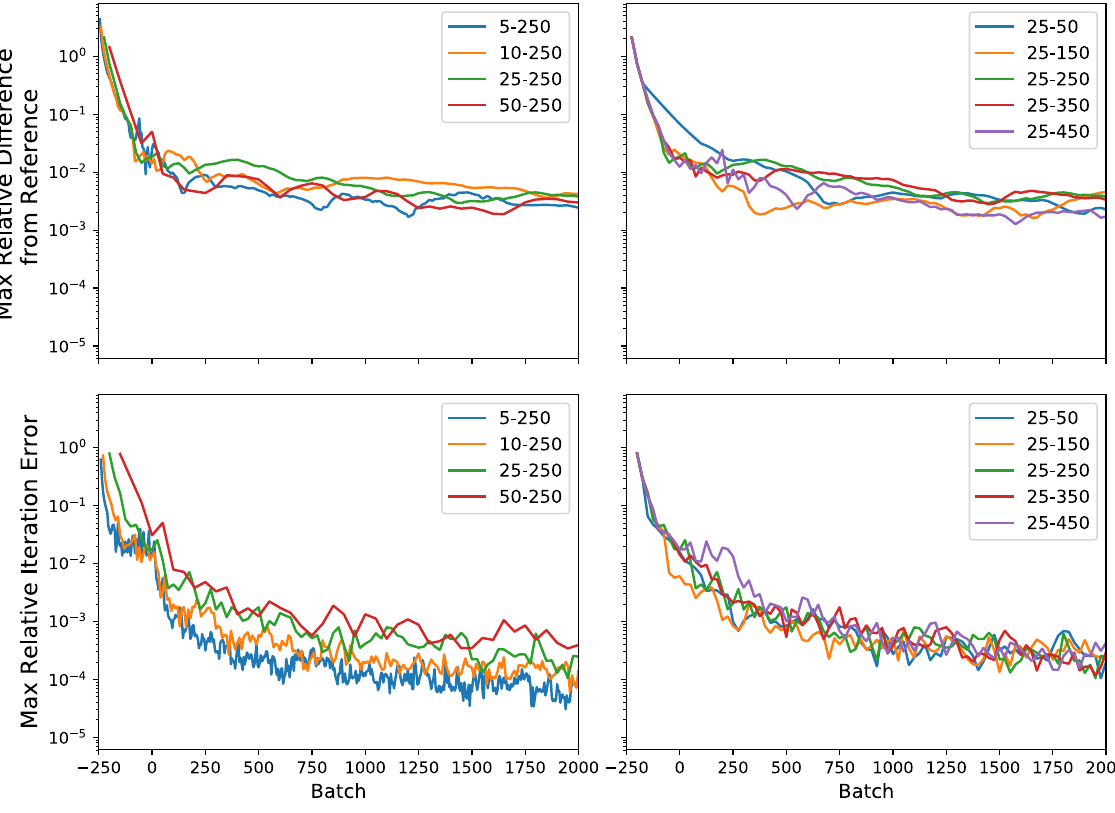
Figure 2: TF (power): Maximum difference from reference and iteration